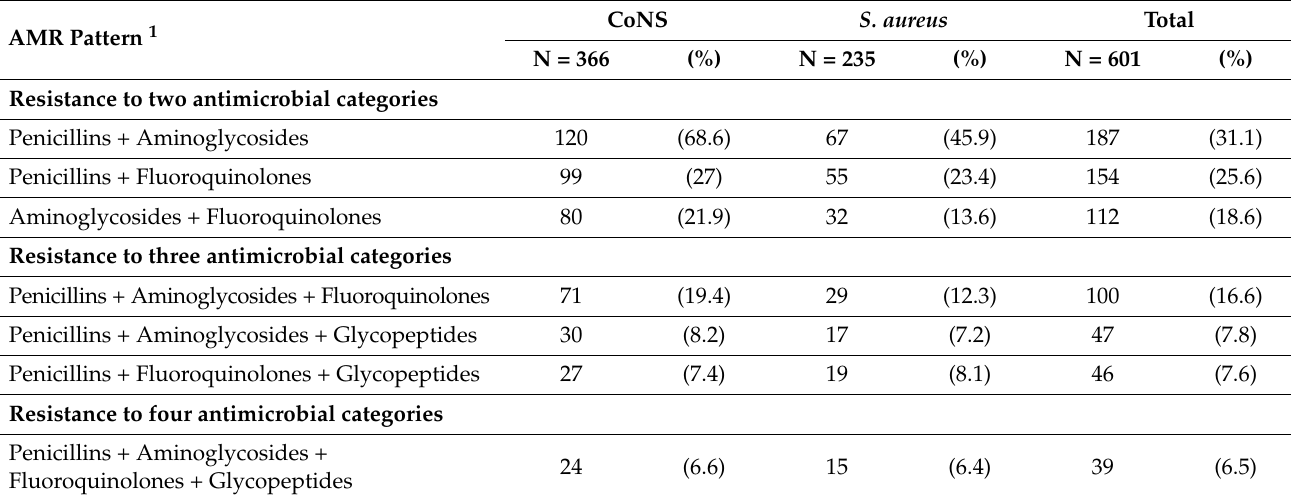
Table 2. Distribution of the antimicrobial resistance (AMR) combination among Gram-positive organisms by bacterial species and tested antimicrobial